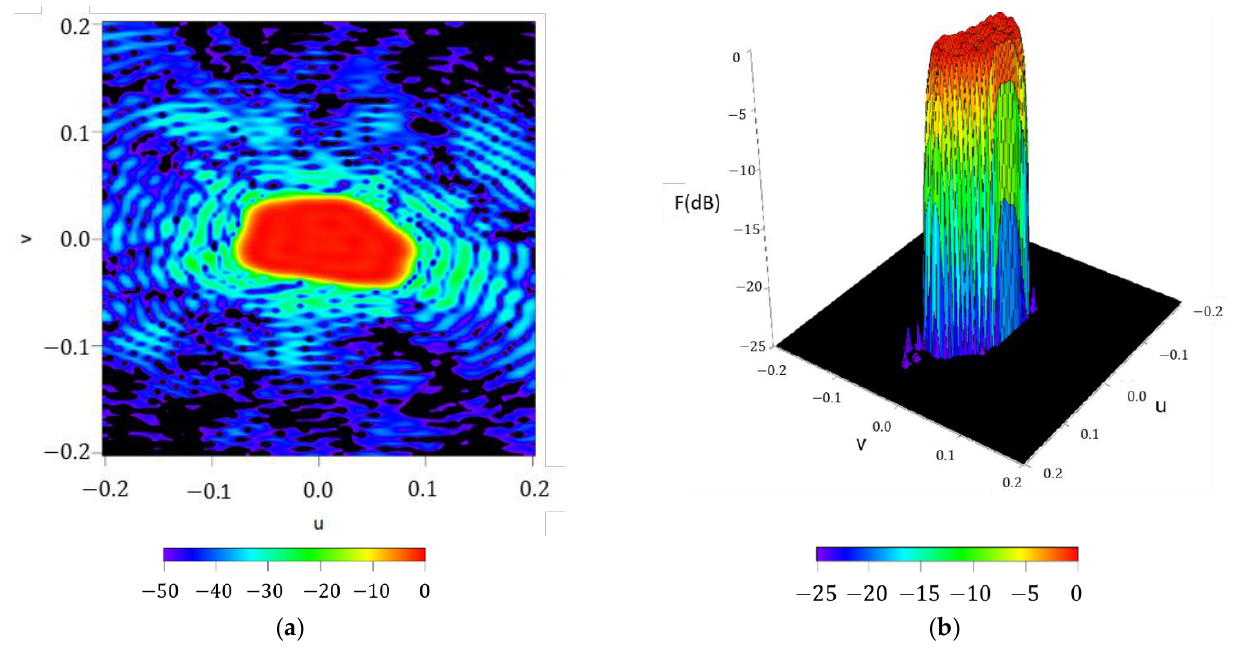
Figure 15. Reconstructed pattern for the case of the continental Europe footprint covered by the EuTELSAT (European Telecommunications Satellite Organization) satellite by means of a discretized array antenna: ( a ) interpolated image with a threshold level set at − 50 dB;( b ) surface plot with a threshold level set at − 25